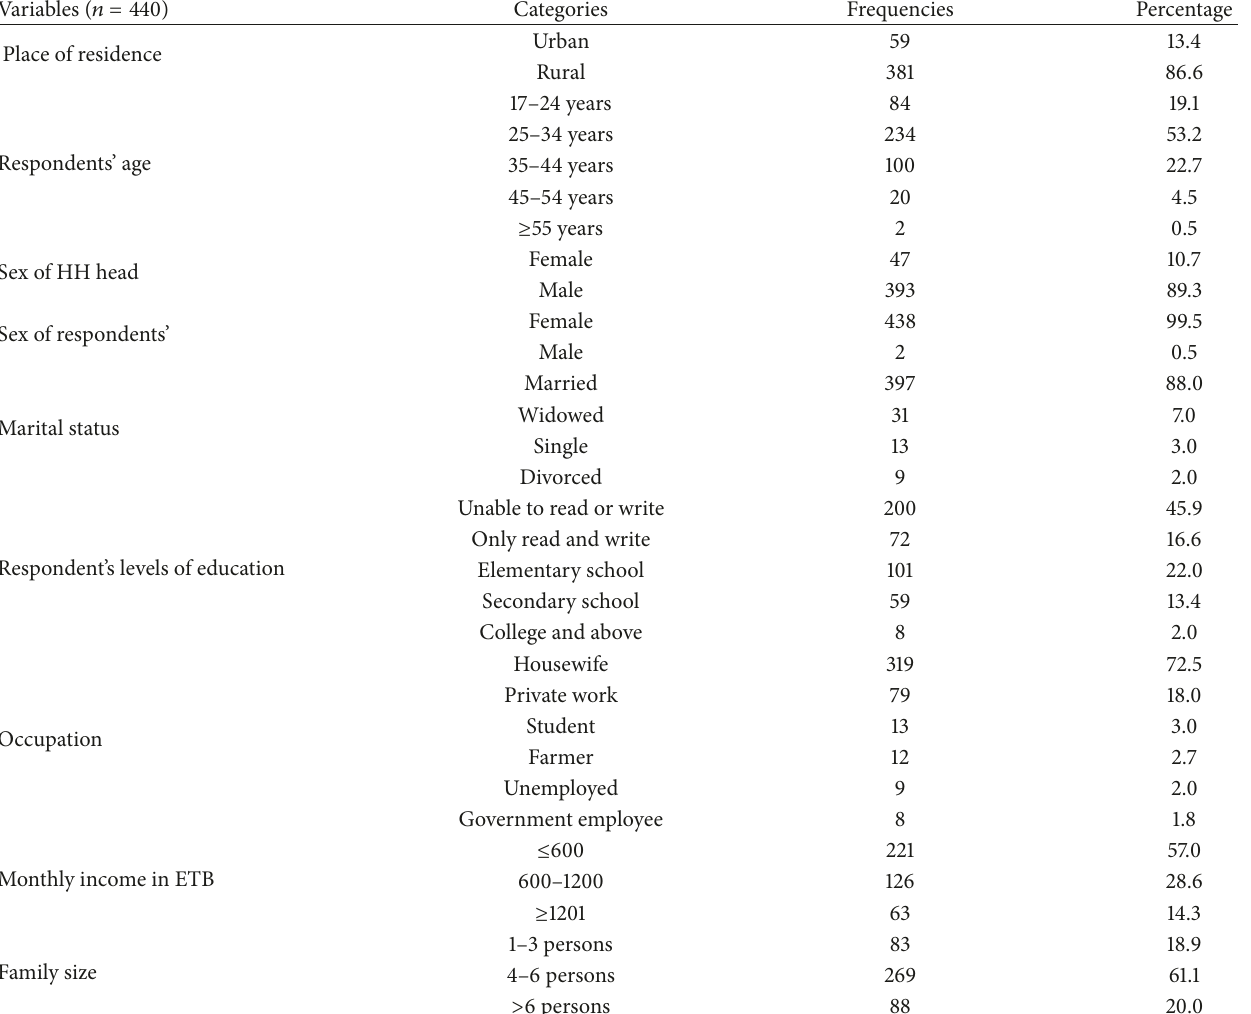
Table 1: Sociodemographic characteristics of the respondents, Wolaita Sodo town and its peripheries, Southern Ethiopia 2016. Variables ( 𝑛 = 440